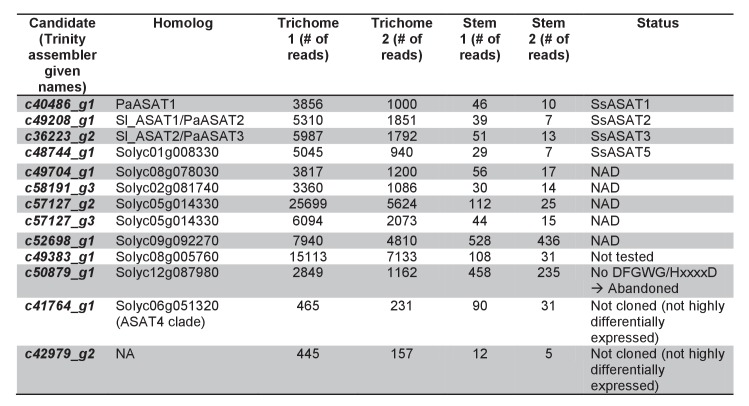
Trichome preferentially expressed BAHD enzymes.Additional information about the transcripts is provided.